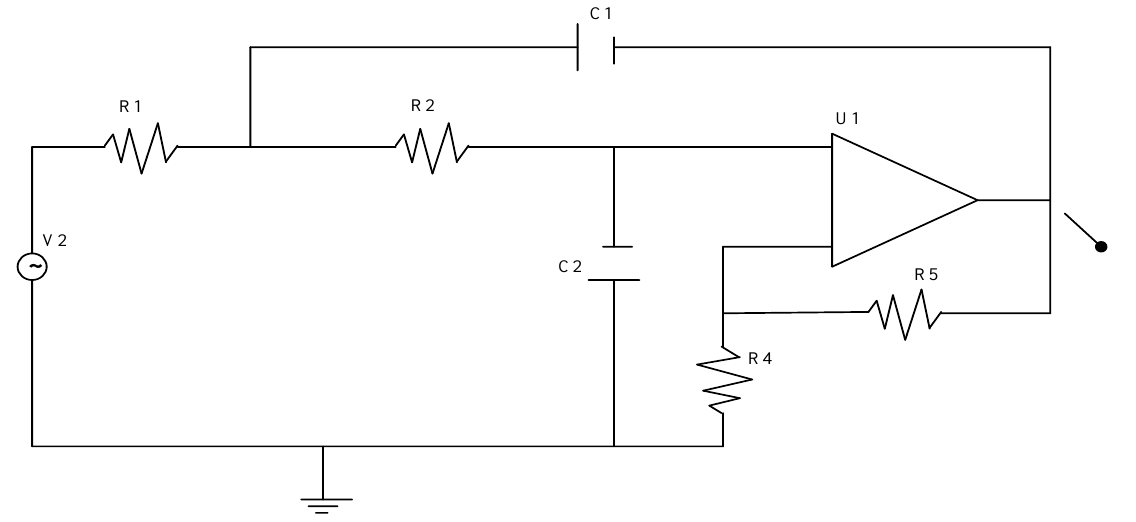
Figure 4. Sallen – Key low-pass filter circuit diagram. Figure 4. Sallen–Key low-pass filter circuit